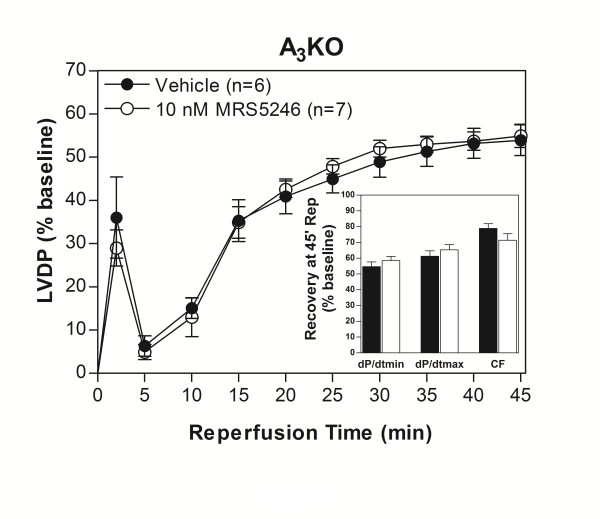
Hearts from A3KO mice exposed to 10 nM MRS5246 did not show improved functional recovery after I/R compared to control indicating the effects of MRS5246 were mA3AR-specific.